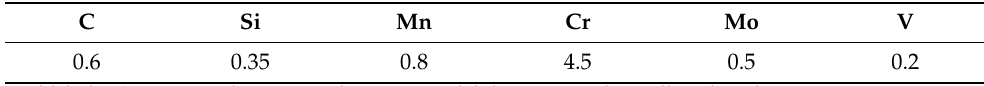
Table 1. Chemical composition of CALMAX * steel (weight %). C Si Mn Cr Mo V